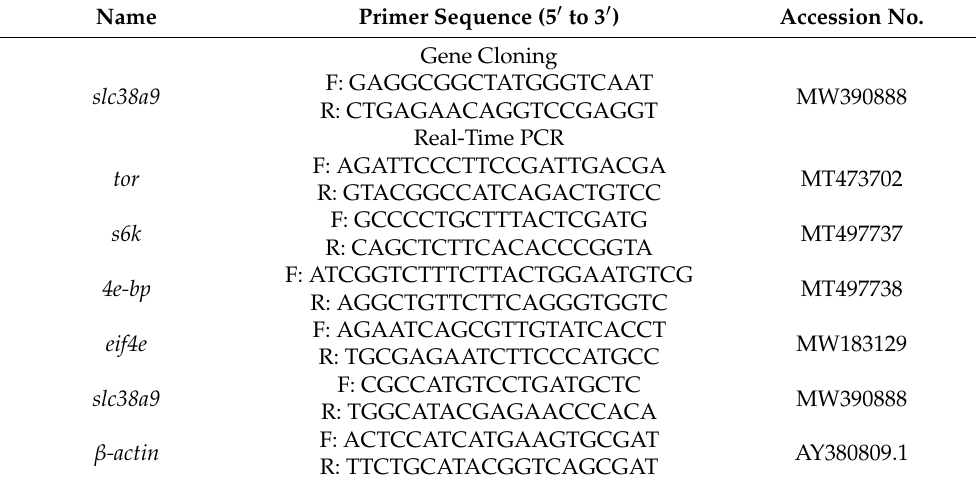
Table 1. Sequences of primers for gene cloning and